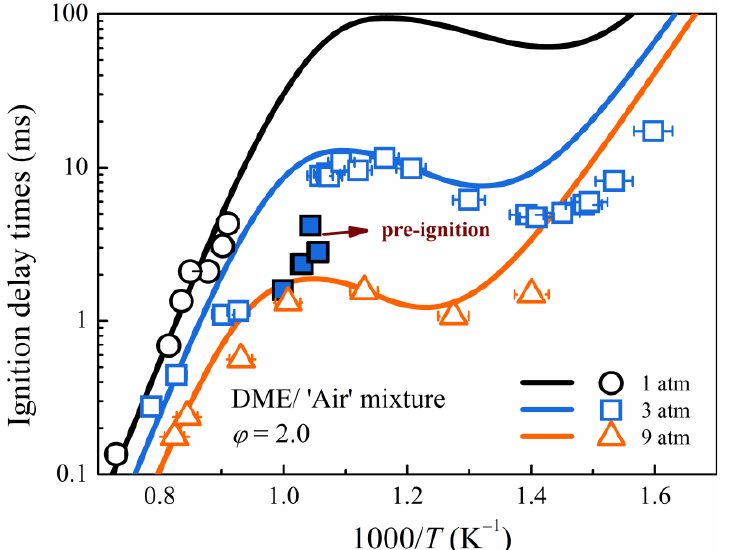
Figure 4. Measured and simulated ignition delay times of PHI2.0 DME/‘air’ mixture at different pressures. Symbols represent experimental data in this study. Lines represent model predictions using AramcoMech 3.0 with constant U and V assumptions.